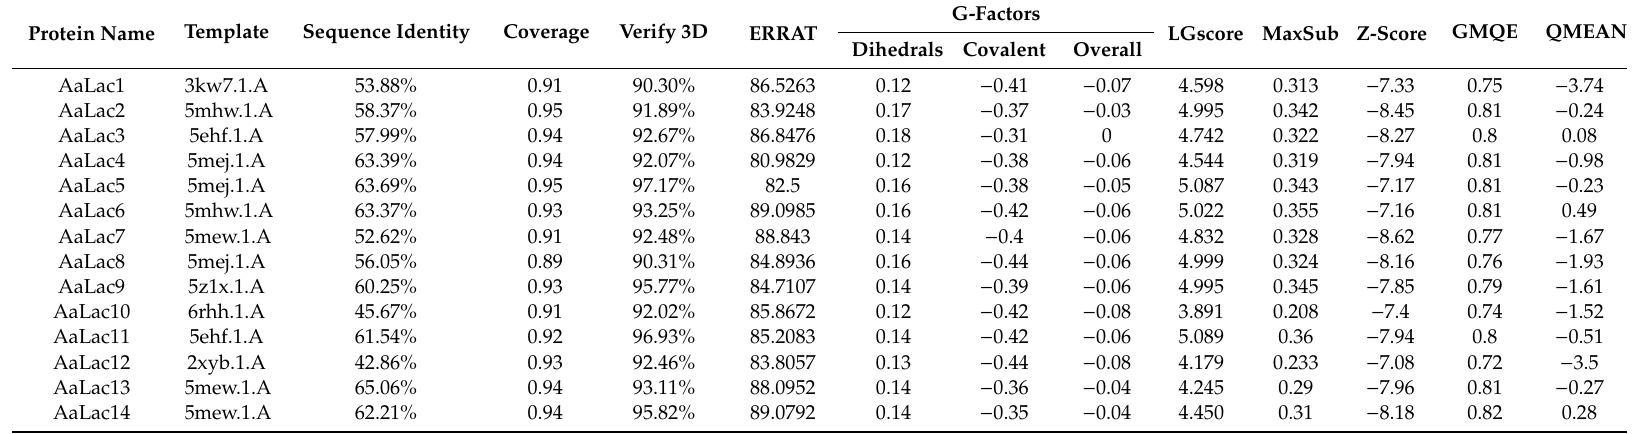
Table 2. Validation of the modeled structures of A. areolatum